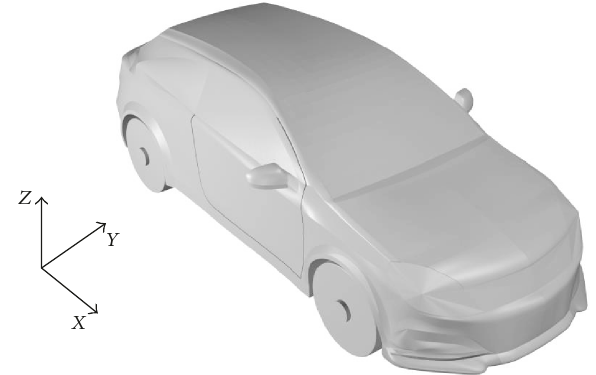
Figure 6: Geometrical model of an Opel Astra car.